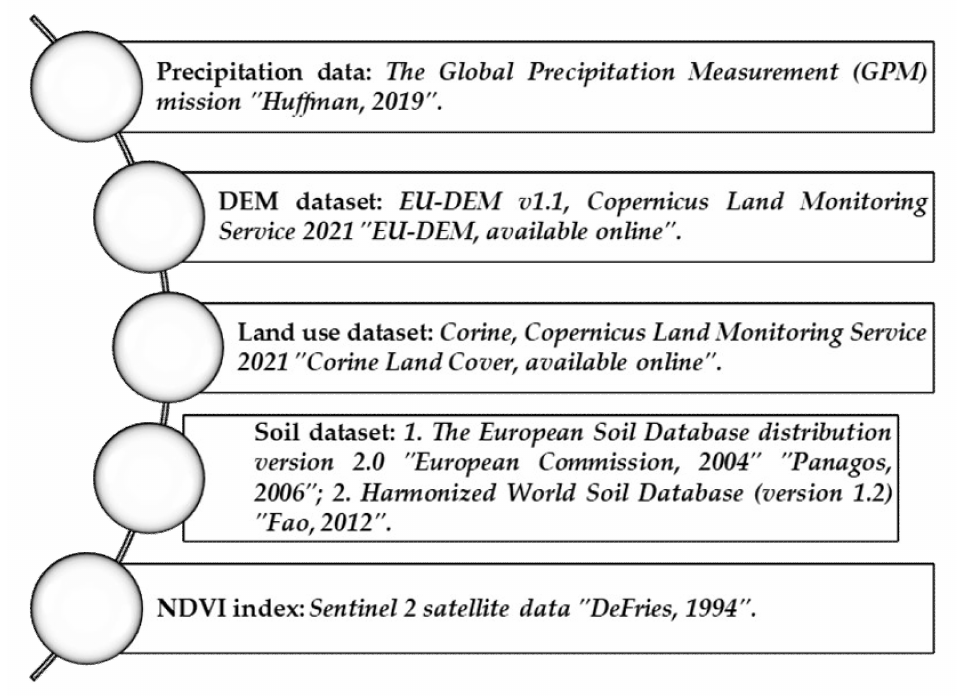
Figure 7. Data used in the application of the RUSLE model and the corresponding sources (Precipita- tion data [60], DEM [61], Land Use [8], Soil Dataset [62,63], Harmonized World Soil Database [64], NDVI index